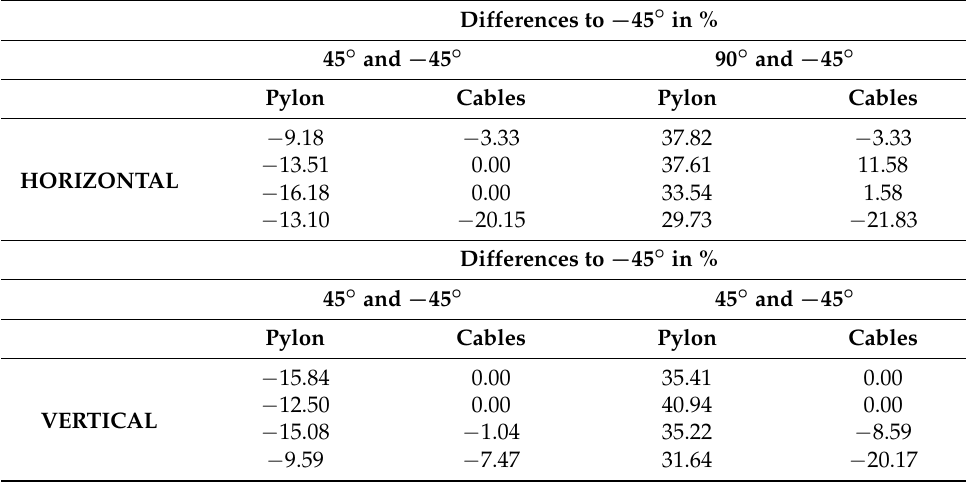
Table 8. Sensibility analysis of the influence of the angle to the − 45 ◦ position.